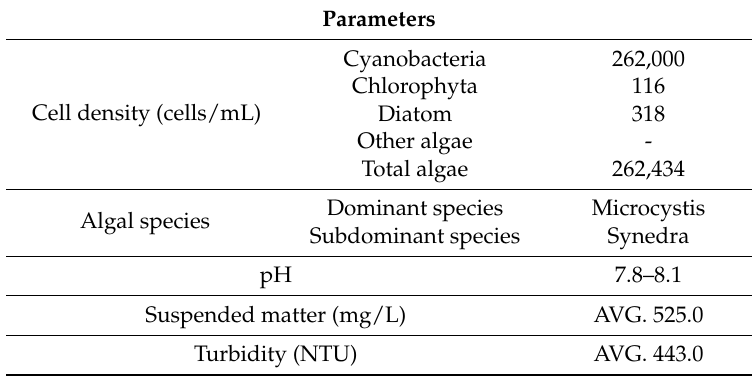
Table 1. Characteristics of the raw